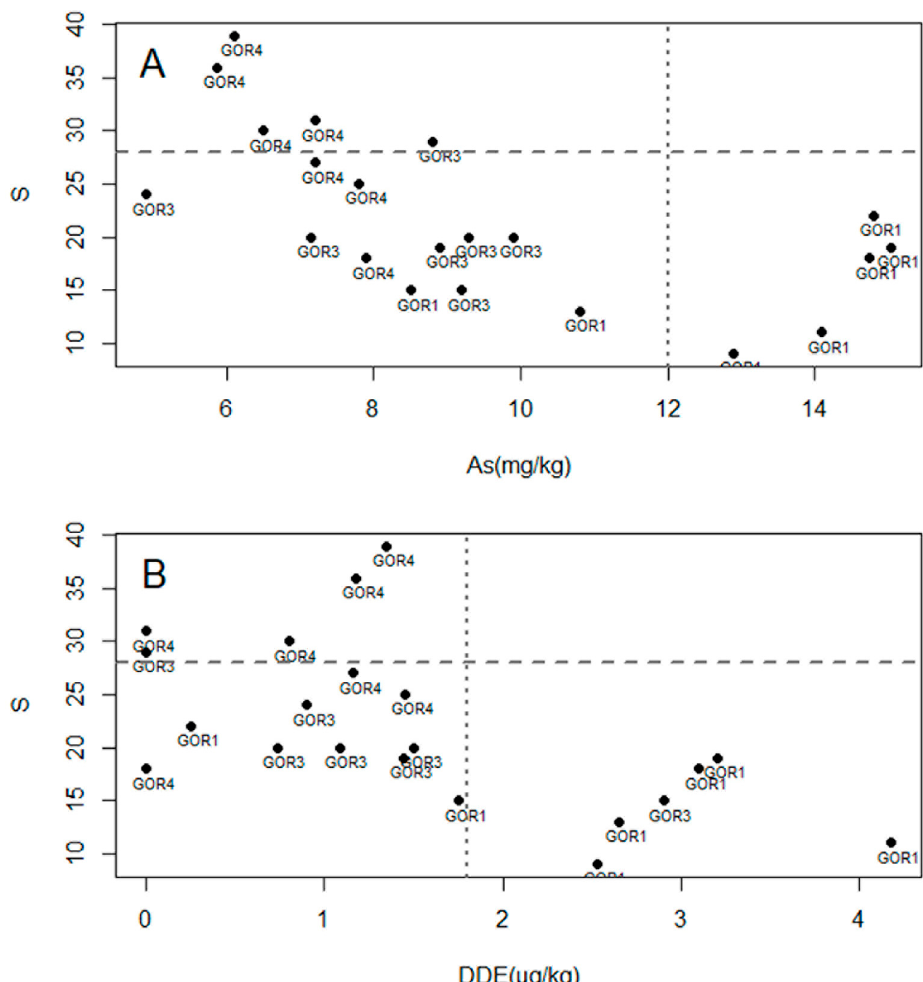
Figure 5. Values of species richness (S) against the concentration of As ( A ) and DDE ( B ), with threshold values for S (high/good, horizontal dashed line), As, and DDE (good/moderate, vertical dotted line), defined by National Law (n = 3).